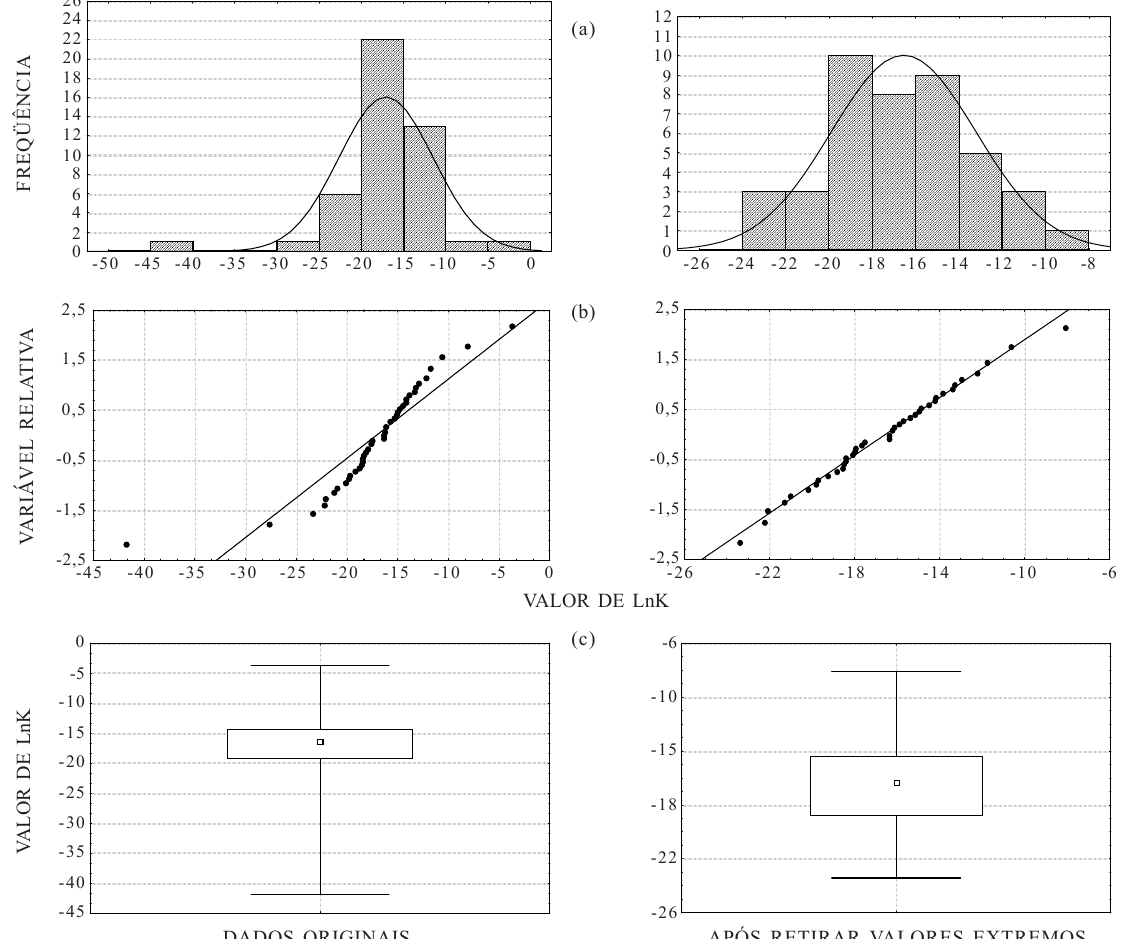
DADOS ORIGINAIS APÓS RETIRAR VALORES Figura 4. Histogramas de freqüência (a), retas de probabilidade de Henry (b) e gráfico “box-plot” (c), para lnK θθθθθ , na profundidade de 0,30 m. = 0